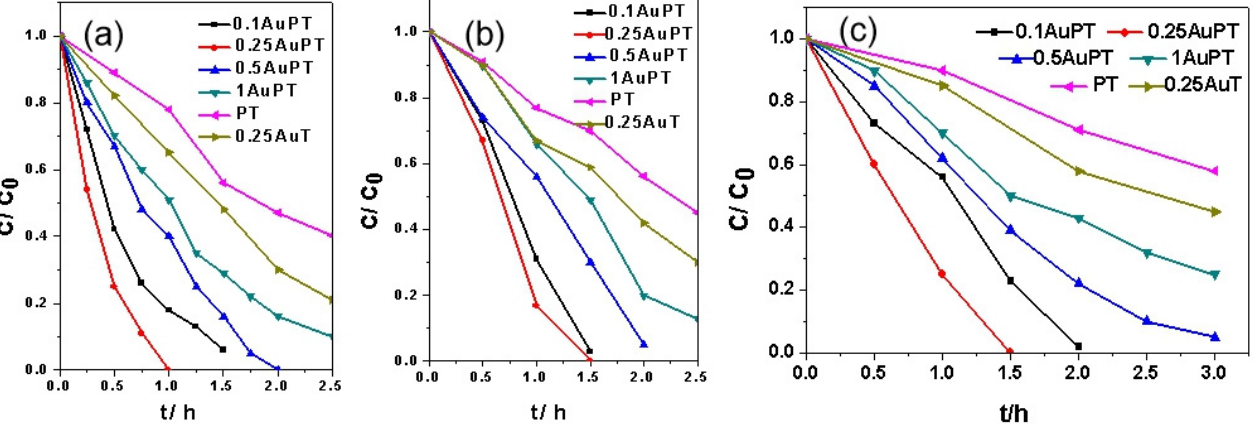
Figure 5. Photocatalytic degradation of ( a ) RhB, ( b ) MO, and ( c ) phenol on fresh i AuPT, PT, and Au/TiO 2 (denoted as 0.25 AuT) catalysts under visible light ( λ ≥ 420 nm). Reaction conditions: photocatalyst content: 1 g L − 1 ; C 0 = 5 ppm.